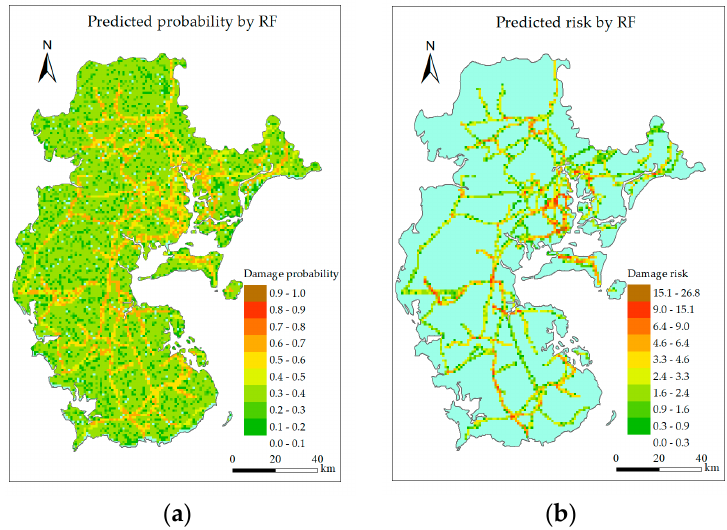
Figure 10. Prediction results of RF. ( a ) Predicted damage probability. ( b ) Predicted damage risk.